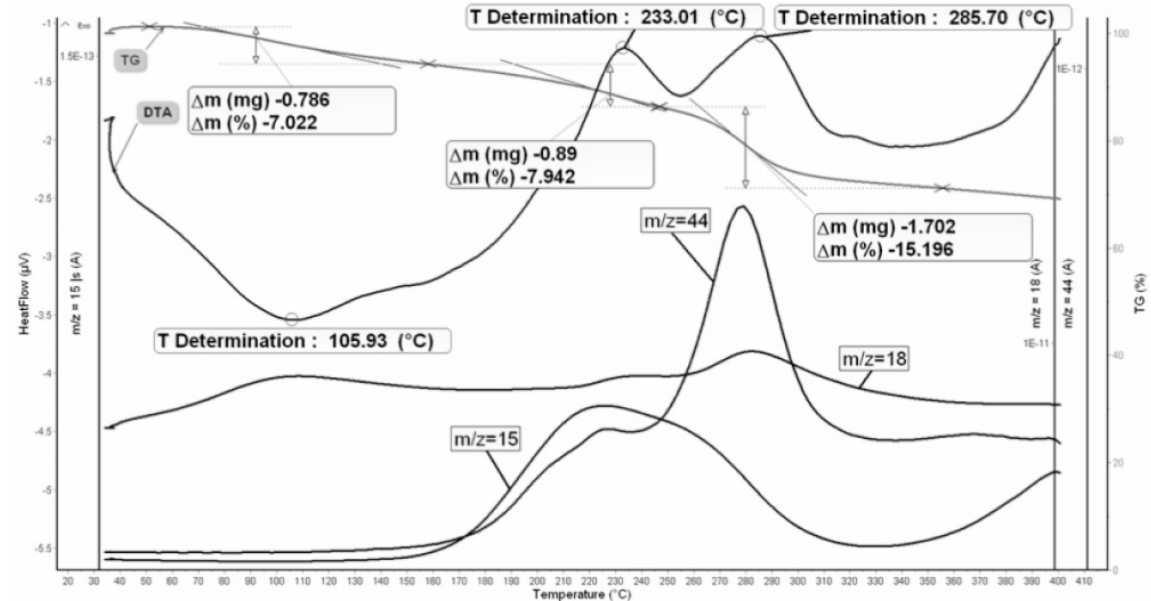
Figure 2. DTA/TG curves 90TiO 2 .10TeO 2 gel.